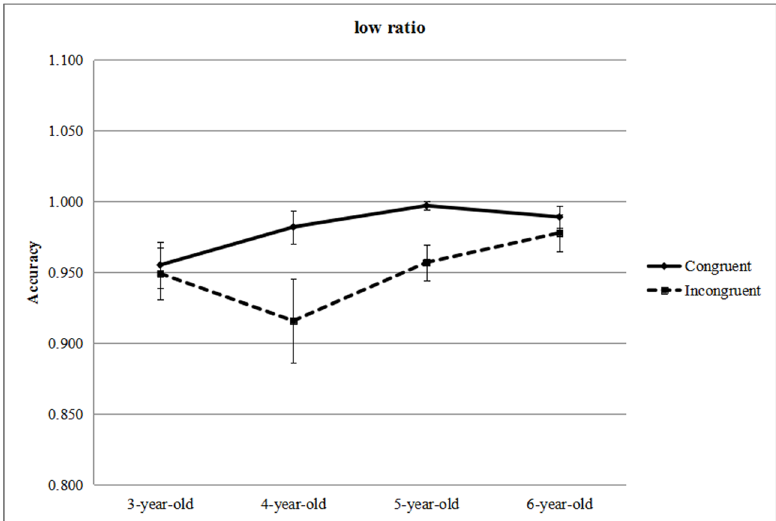
Fig 3. Accuracy results of interaction of age and condition in low ratio. (Error bars showed the standard errors).